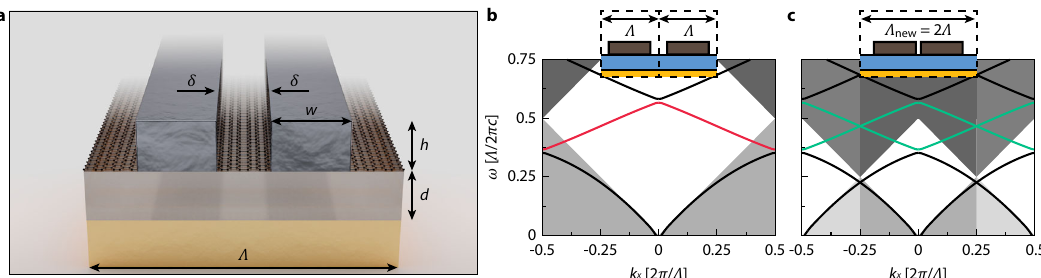
Fig. 2 Schematic of the metasurface and the band structure of the gratings. a Schematic of the metasurface. The graphene is patterned into nanoribbons between the Si pillars, forming graphene plasmons within a cavity. The Si pillars are grouped into dimers, resulting in a quasi-BIC from broken (doubled) periodicity of the Si grating. b The optical band structure before the dimerization of the pillars. The red line indicates the antibonding mode we will be utilizing. c The band structure after the dimerization of the pillars. Periodicity doubling causes zone folding, bringing in the modes that were previously inaccessible to free-space light into the light cone. The green line indicates the qBIC (antibonding mode). The white diamond region represents the 0th- order